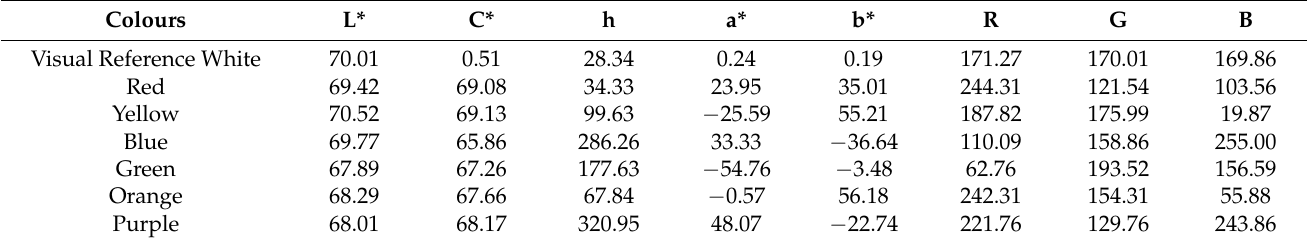
Table A1. The characteristics of the background colours of the monitor.